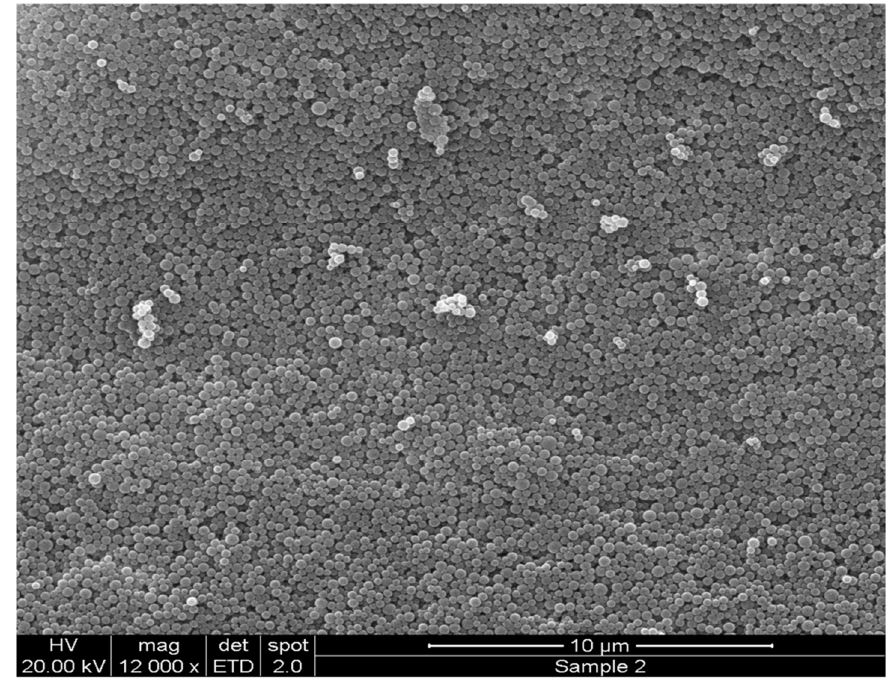
Figure 2. Scanning Electron Microscope (SEM) images of NT 3–12 peptide-loaded 10% PEG-PLGA NPs (F7) after formulation.